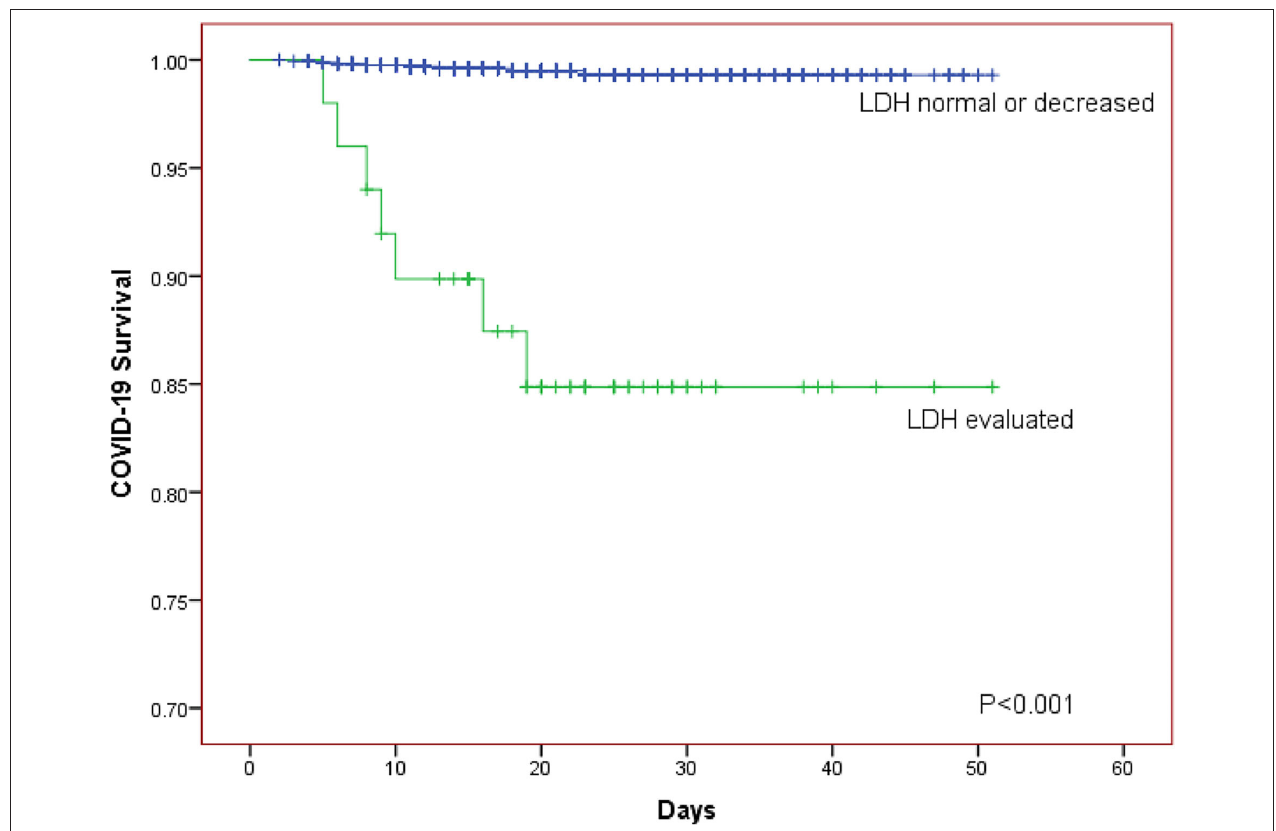
FIGURE 2 | The Kaplan-Meier curves for the survival of COVID-19 patients in different LDH level (normal or decreased group, evaluated group).